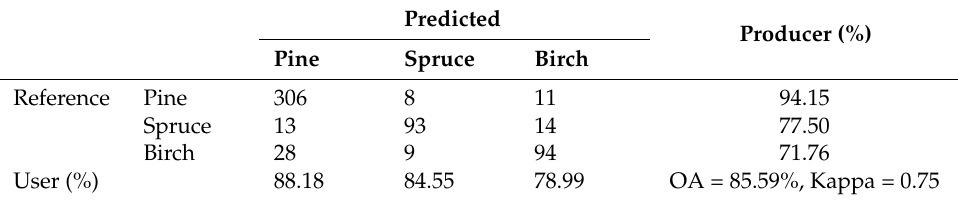
Table 8. Confusion matrix and accuracy evaluation of classification with 15 selected features among all features and test data.